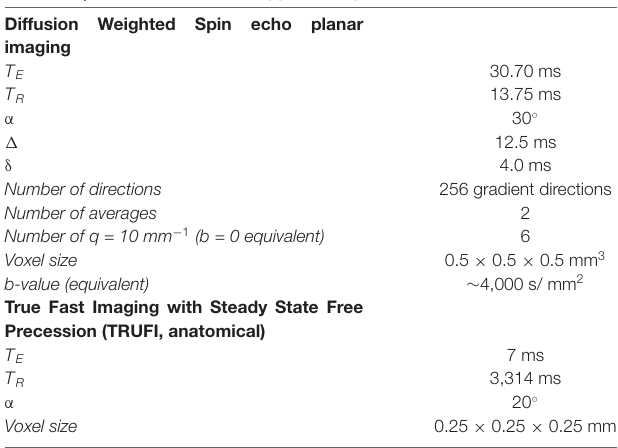
TABLE 2 | Characteristics of the applied MRI